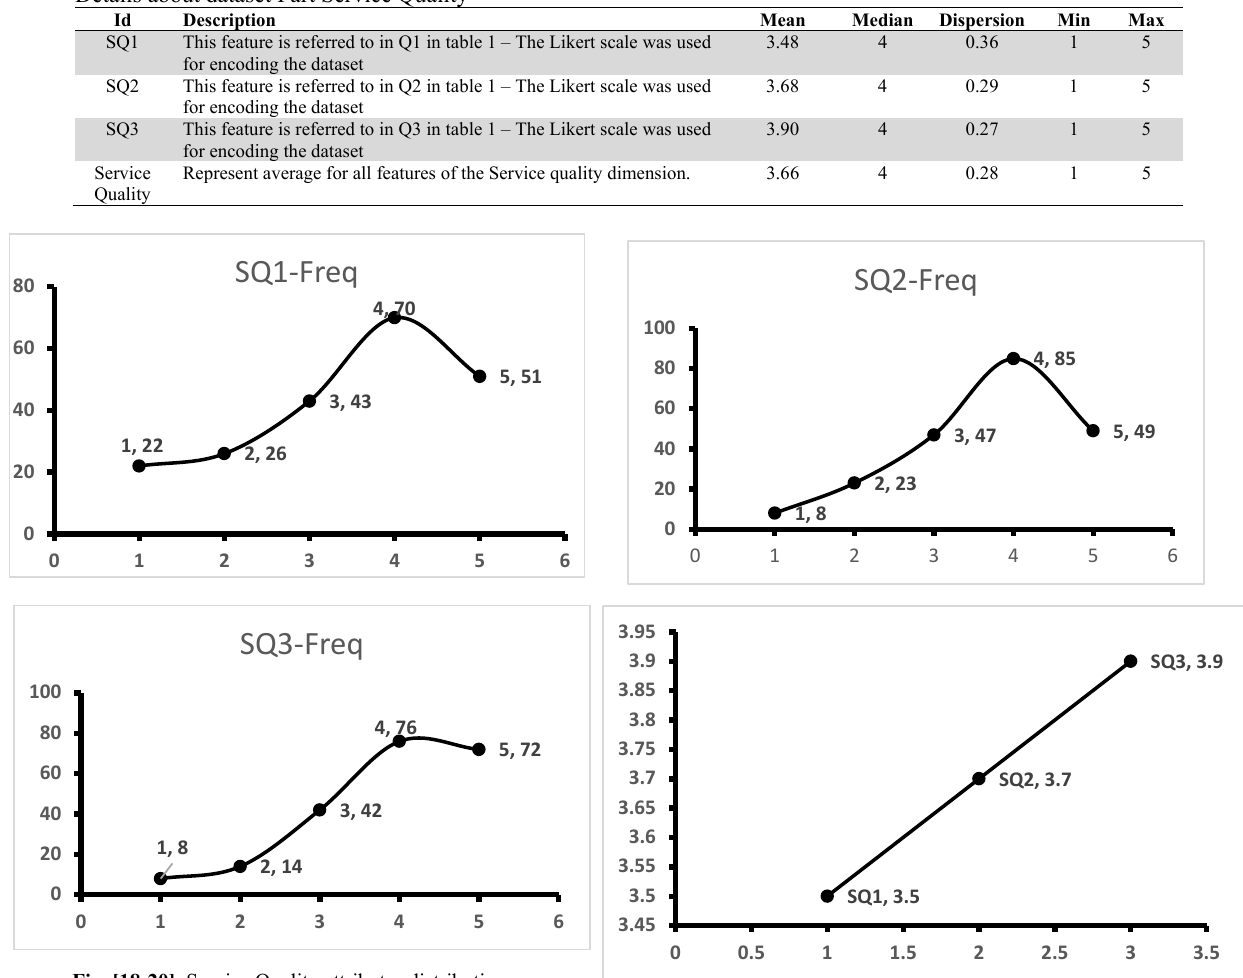
Fig. 21. Service Quality Attributes indicators